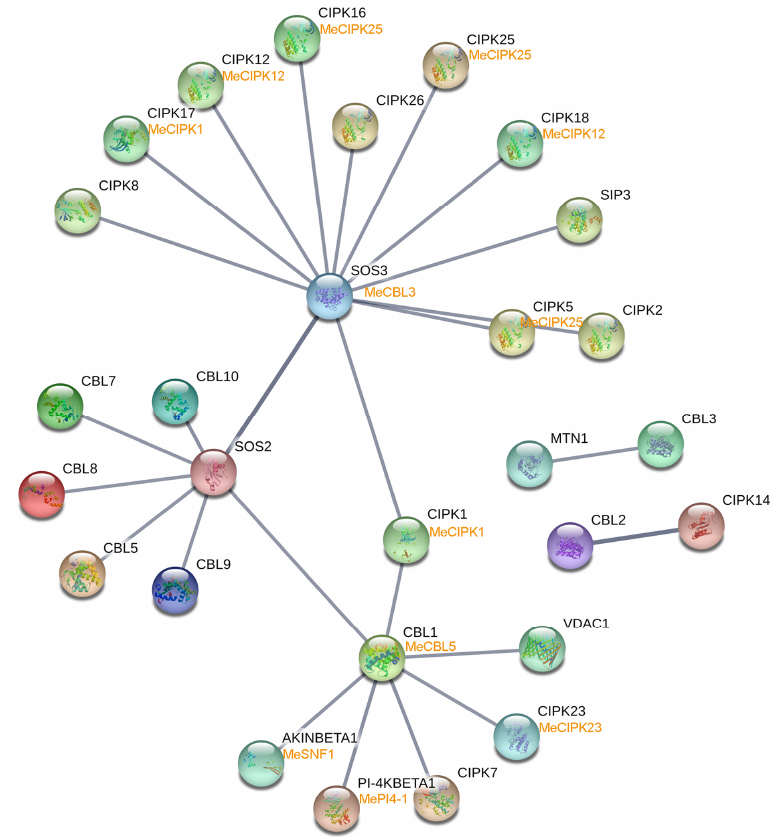
Figure 5. Interaction network and co-expression analyses of CBLs at 48 h/0 h in cross-sessions of SR after harvest. The interacting relationship between CBLs and other proteins are indicated by the gray lines. The genes at upper and lower around each ball show CBL-mediated interaction network in Arabidopsis and cassava, respectively. The gene pairs that showed uniform upregulation (Log 2 based fold change > 1) at 48 h/0 h after harvest in cassava were marked with yellow.